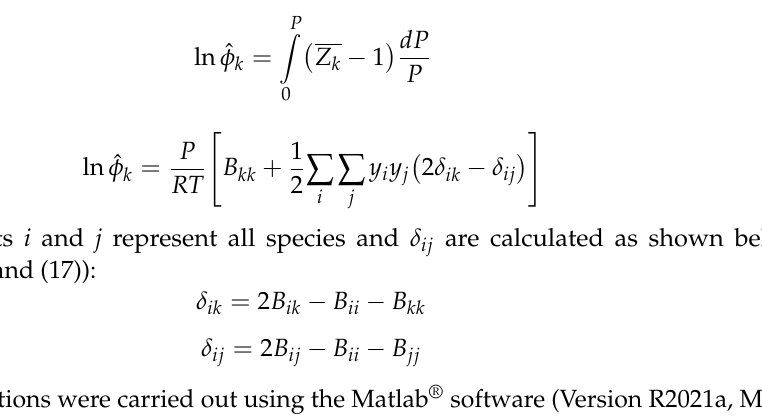
mass 1 mg. Figure S4: IR spectra for carrier used in the nanofluid for steam injection